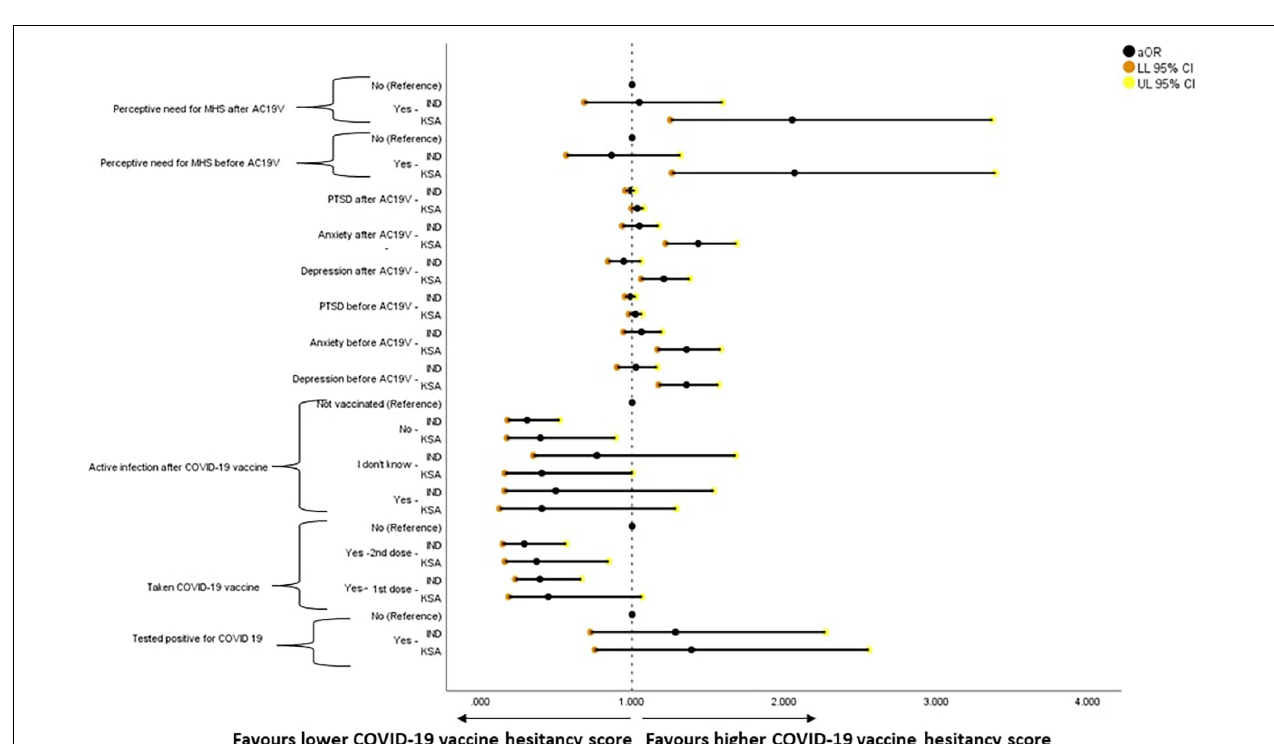
FIGURE 4 | Forest plot showing adjusted binary logistic regression analysis of COVID-19 vaccine hesitancy (regression model 2). aOR, adjusted Odds Ratio; Odds ratio adjusted for Sociodemographic factors. 95% CI—95% Confidence Interval. The results of regression model 1, 2, and 3 in binary logistic regression analysis of COVID-19 Vaccine Hesitancy is tabulated in Supplementary Table 11 . Ind–India; KSA–Kingdom of Saudi